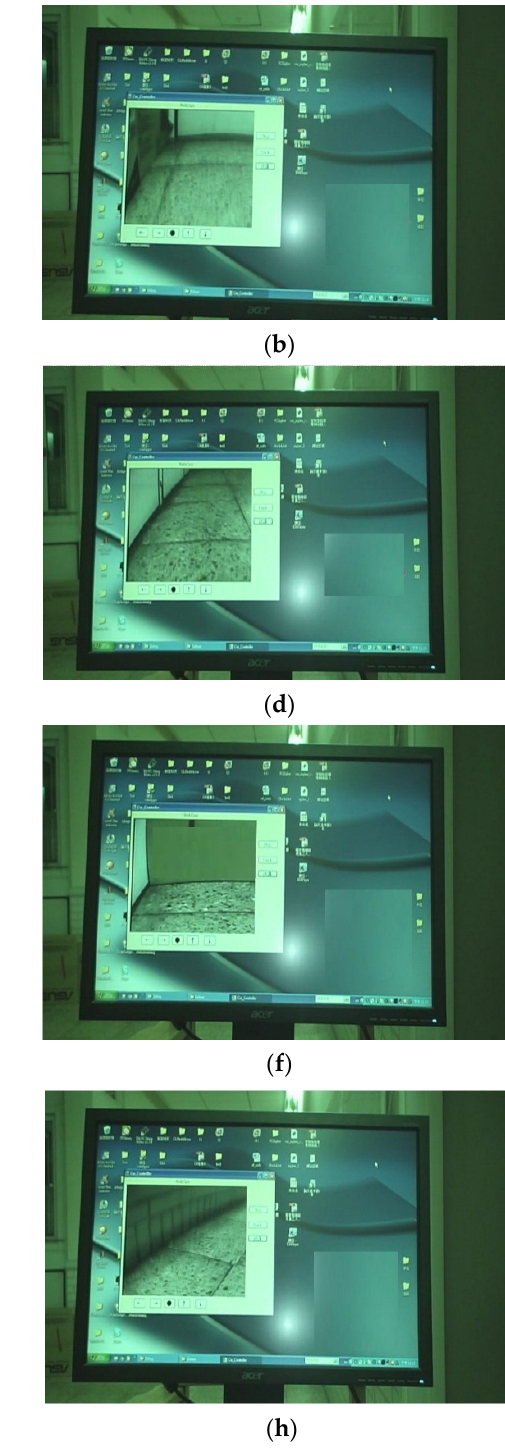
Figure 26. Wall ‐ following patrol. ( a ) Initial position; ( b ) Wall ‐ following patrol 1 position; ( c ) Patrol 2 position; ( d ) Patrol 3 position; ( e ) Patrol 4 position; ( f ) Patrol 5 position; ( g ) Patrol 6 position; ( h ) Ending position.